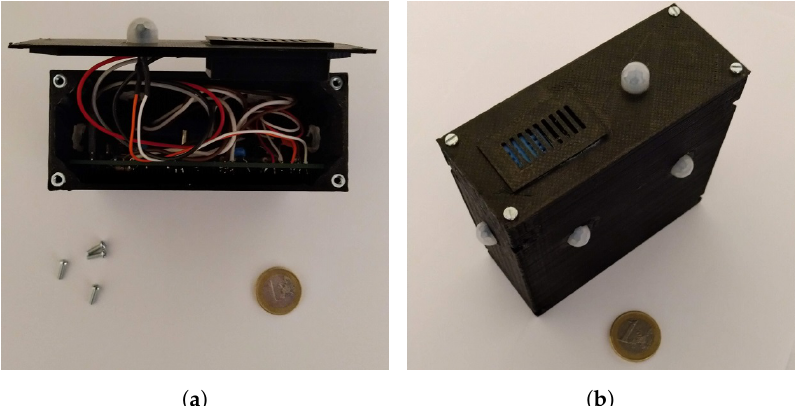
Figure 7. Developed sensor module 5FTH in the 3D printed case. ( a ) Top view; ( b ) Isometric